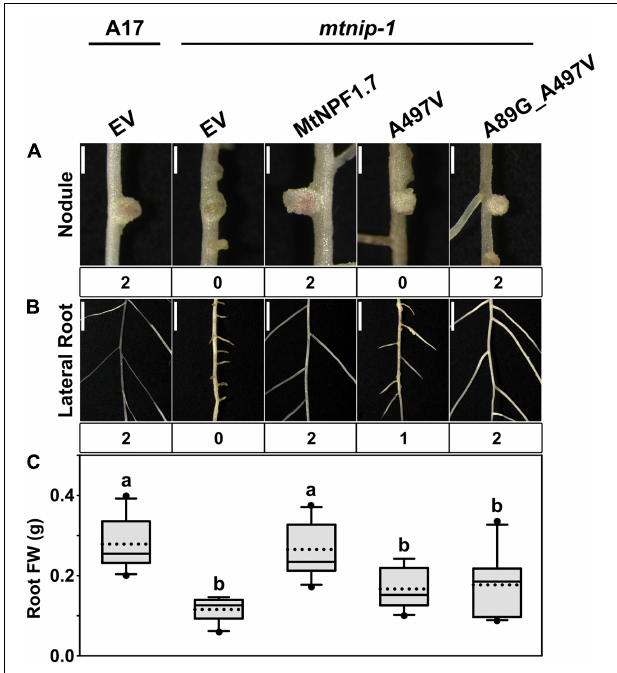
FIGURE 7 | Complementation studies of the mtnip-1 mutant and restored activity. Images showing the phenotypes in (A) nodules and (B) lateral roots of (from left to right) A17 plant roots transformed with pMU06 empty vector (EV), mtnip-1 plant roots transformed with EV, MtNPF1.7_wt (pYCY400), _A497V (pYCY401), and _A89G_A497V (pYCY420). Nodules and lateral roots are evaluated by complementation levels shown below each image as described in Figure 2 . (A) Bars = 1 mm. (B) Bars = 5 mm. (C) Plot of root fresh weight from ten independent transgenic plants. See Figure 2D for statistical